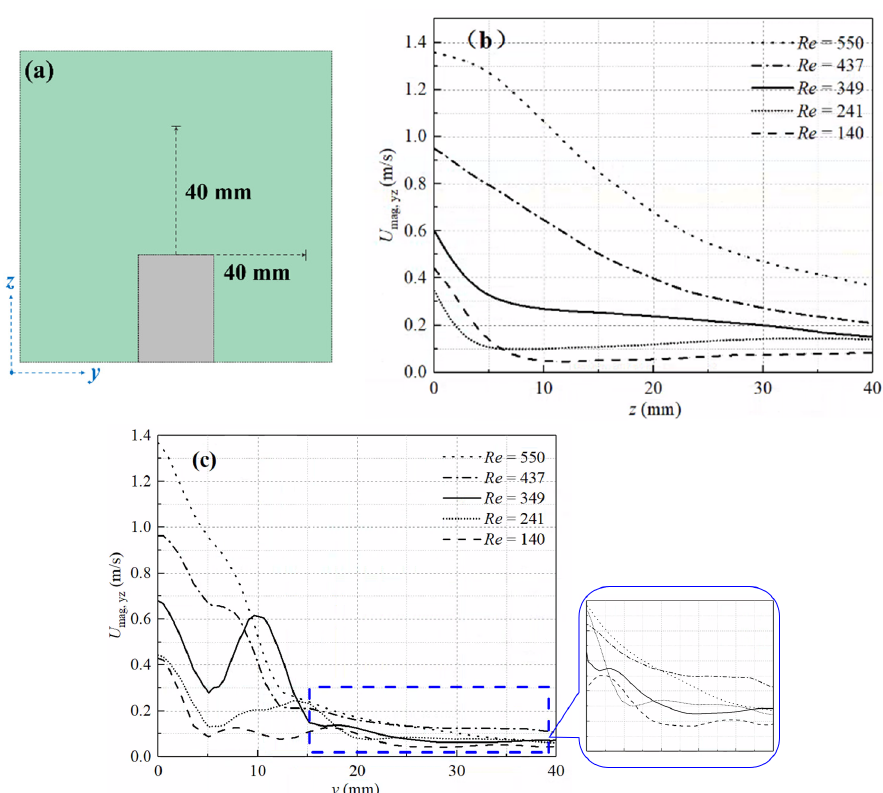
Figure 6. Velocity magnitude at streamwise and spanwise lines: ( a ) schematic of the lines for data extraction, ( b ) velocity magnitude profile of the flow field along the line of y = 0, 0 < z < 40. ( c ) Velocity magnitude profile of the flow field along the line of z = 0, 0 < y <